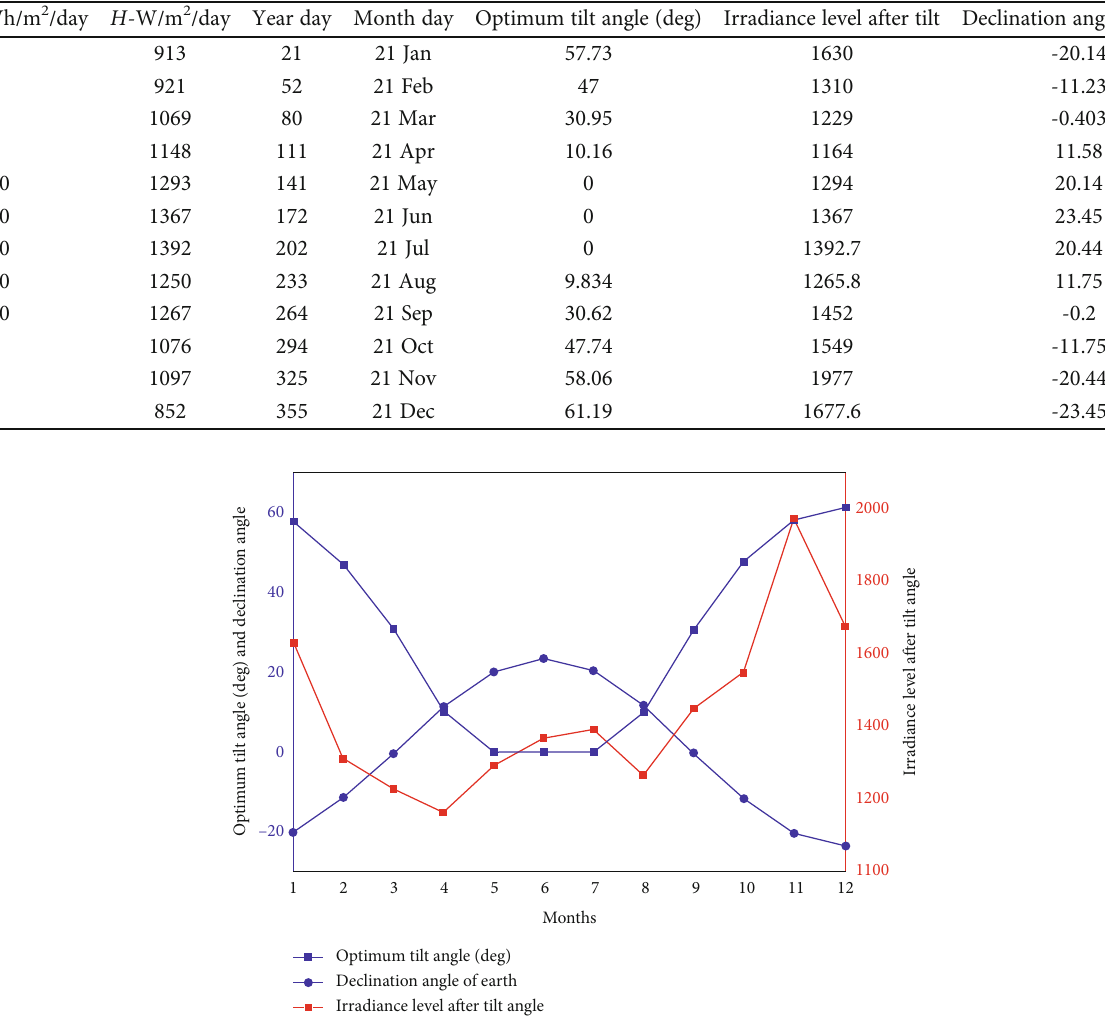
Figure 3: Speci fi c monthly irradiance on variable optimal tilt angle and declination angle versus months. Table 3: Monthly speci fi c daily global irradiance ( H ), year days, days of the month, tilt angle (deg), irradiance level after tilt, and declination angle of the